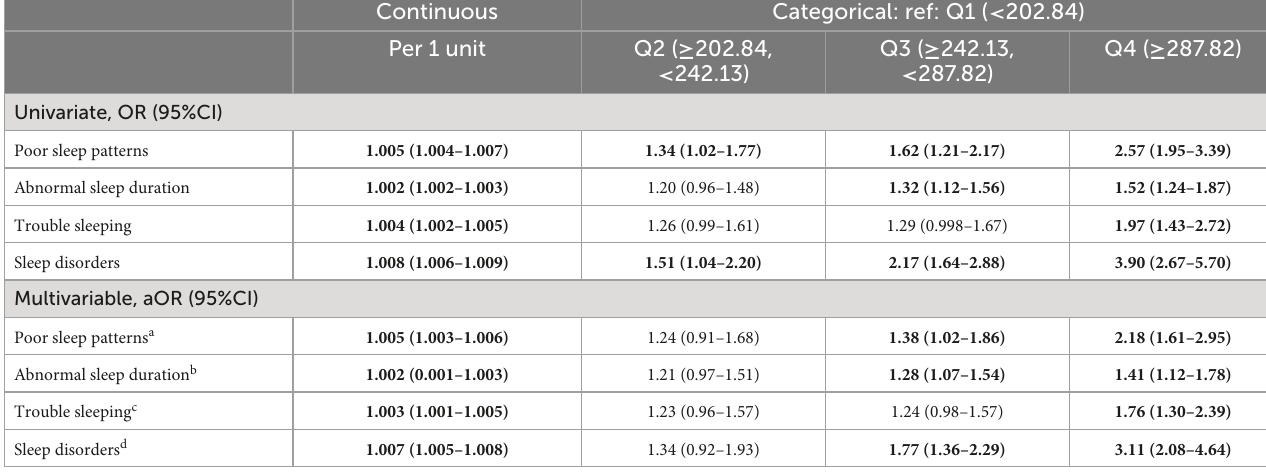
TABLE 3 Associations between TyG-BMI, poor sleep patterns and its